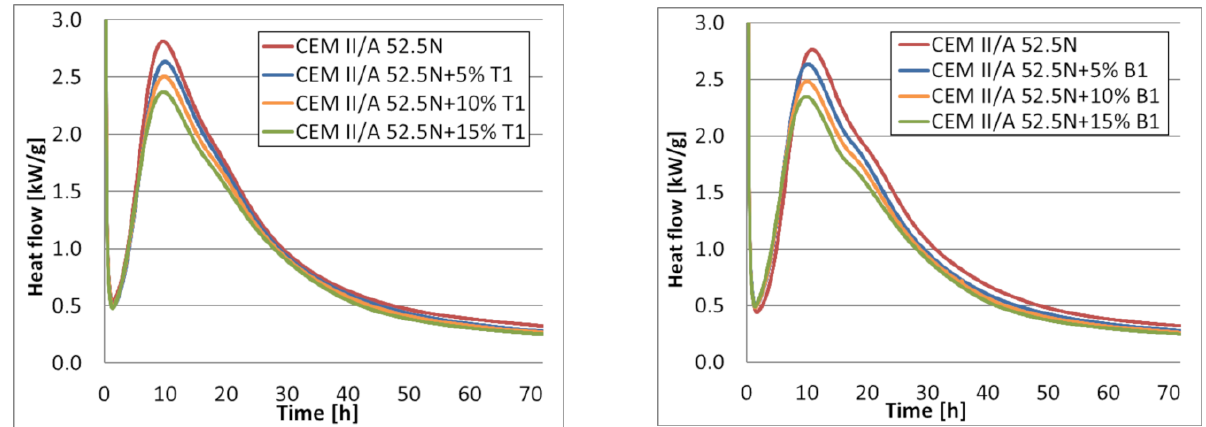
Figure 8. Heat flow of blended cements with limestone T1 and B1.